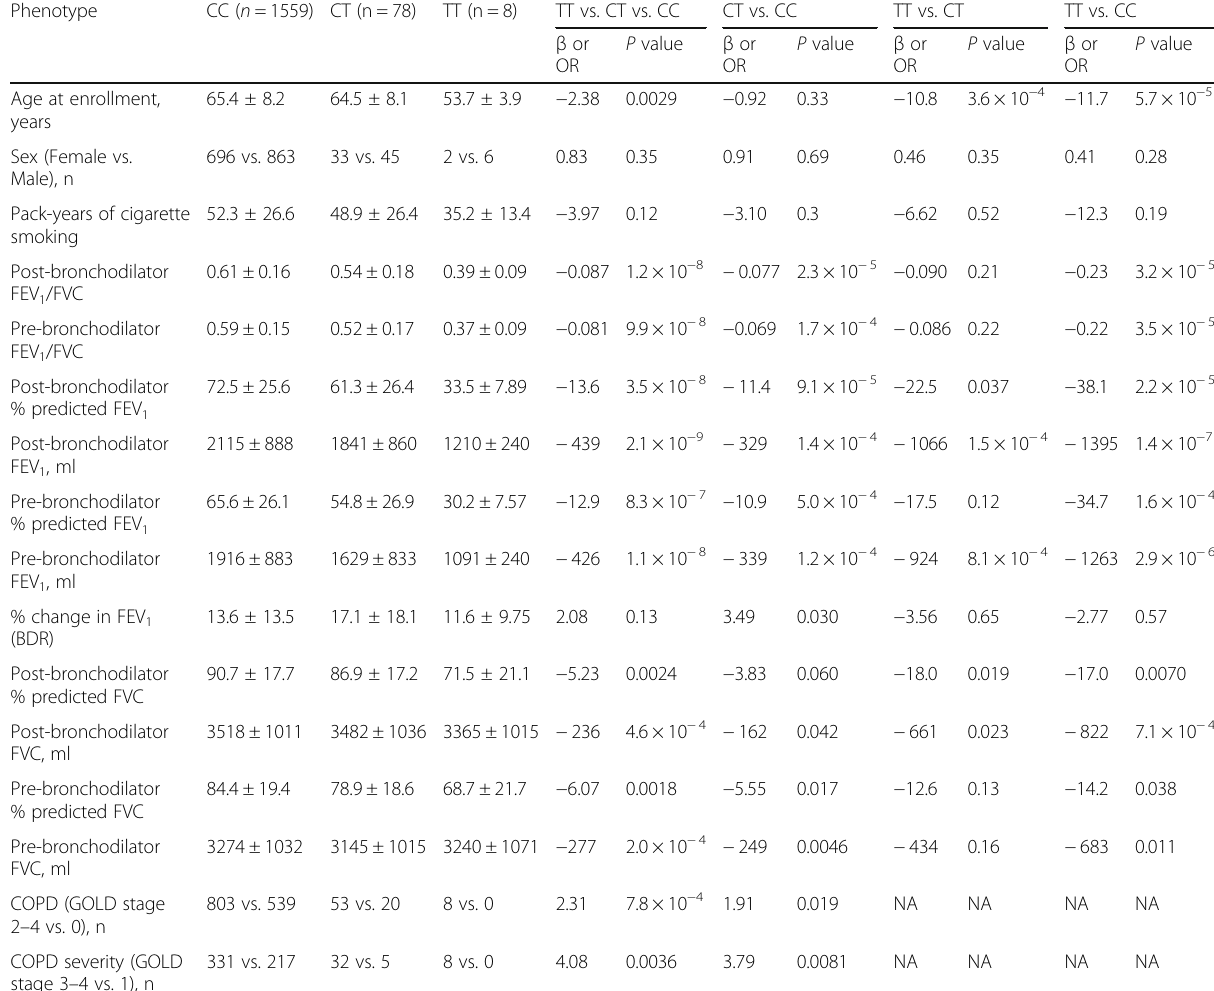
Table 3 Association Results of rs28929474 in SERPINA1 with Lung Function, COPD, and COPD Severity